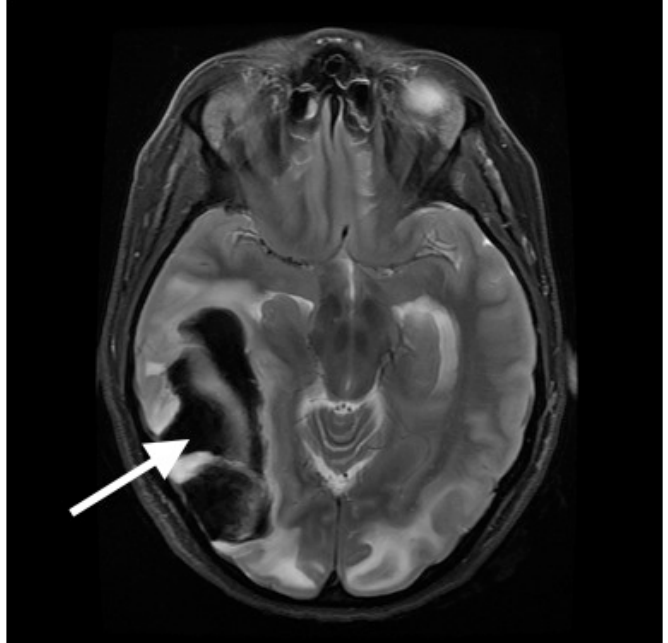
Figure 4. T2 weighted magnetic resonance imaging of Patient 3 on hospital day 4 with massive right-sided temporo-occipital intraparenchymal